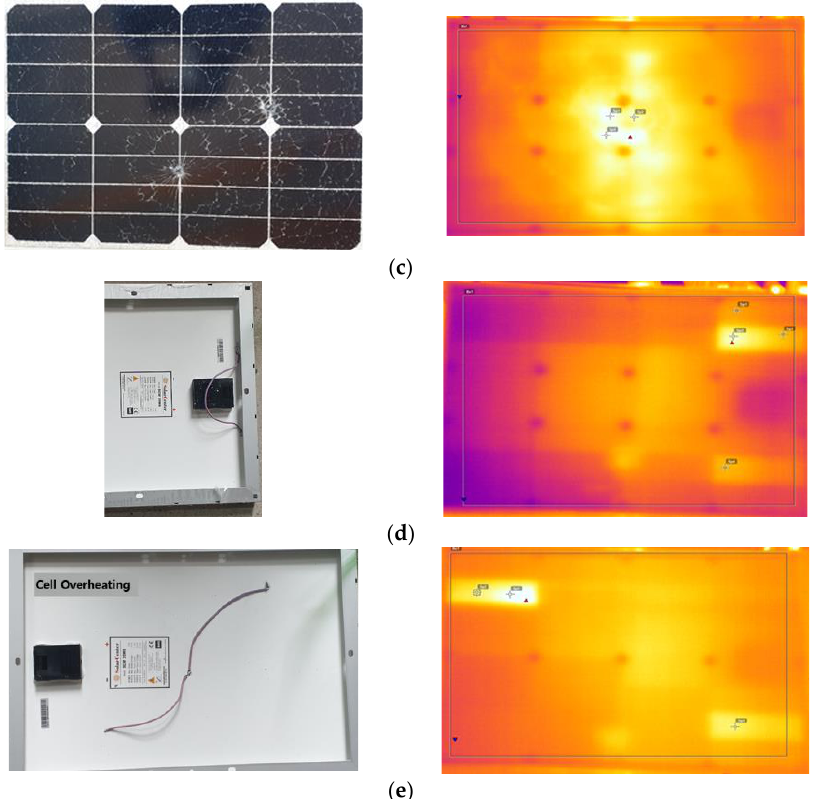
Figure 7. Photographs (left) and thermal images (right) of the 35 W panel with different failure types: ( a ) hotspot, ( b ) connector breakage, ( c ) panel breakage, ( d ) busbar, and ( e ) overheating of panel cells.